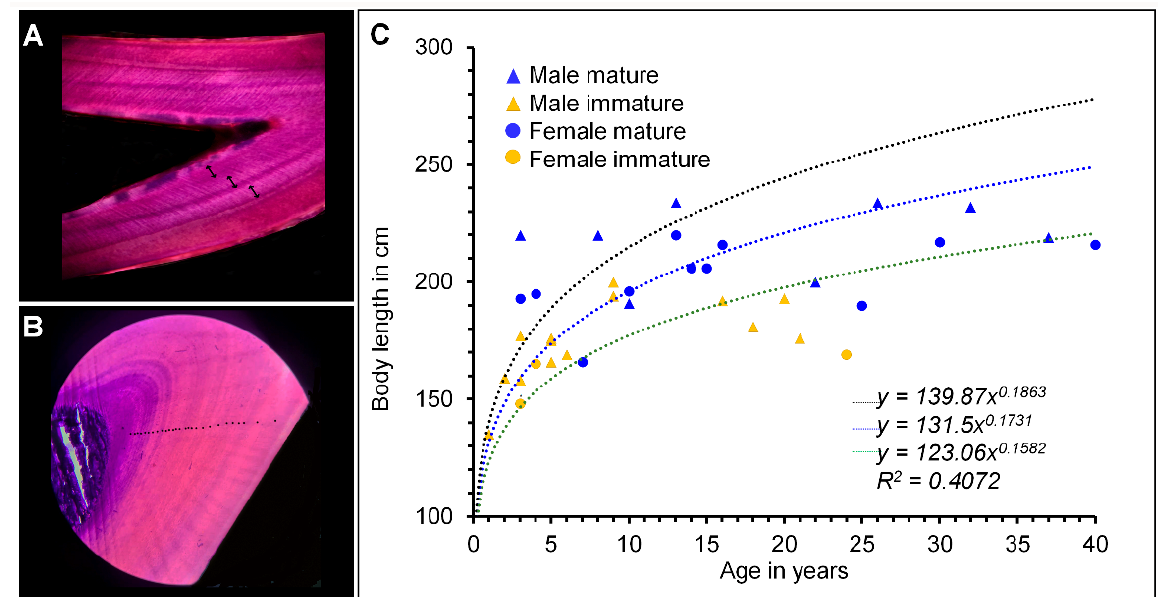
Figure 1. S. coeruleoalba age estimation according to body length and dentinal GLG groups. ( A , B ) Hematoxylin-stained teeth sections show the GLG groups (arrows and dots). ( A ) Female pre-weaned dolphin with 3 GLGs (CR07-19). ( B ) Female adult dolphin with 29 GLGs (CR03-20). ( C ) The dotted curves denote three dolphin age models according to S. coeruleoalba body length [6,7,52–54]. R 2 is the proportion of variation according to GLGs with body length. (Supplemental Data S1).